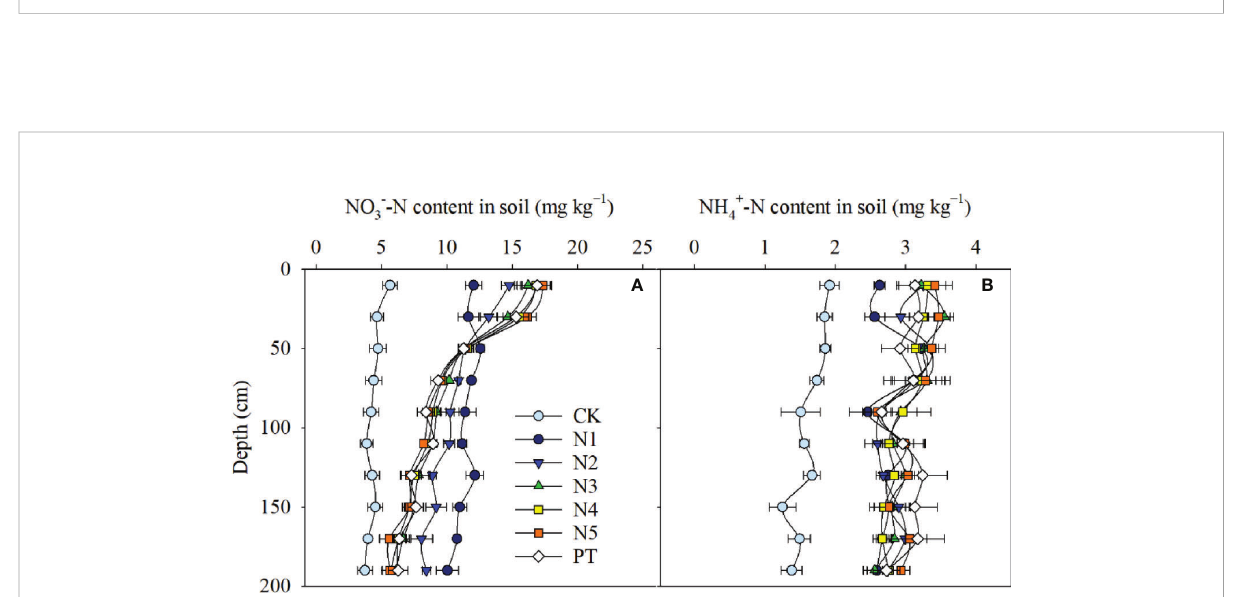
FIGURE 7 NO 3 − -N content (A) and NH 4+ -N content (B) at 20 cm intervals from 0 to 200 cm after maize harvest in different N application treatments over three years. PT, contents at beginning of experiment. Error bars represent the standard